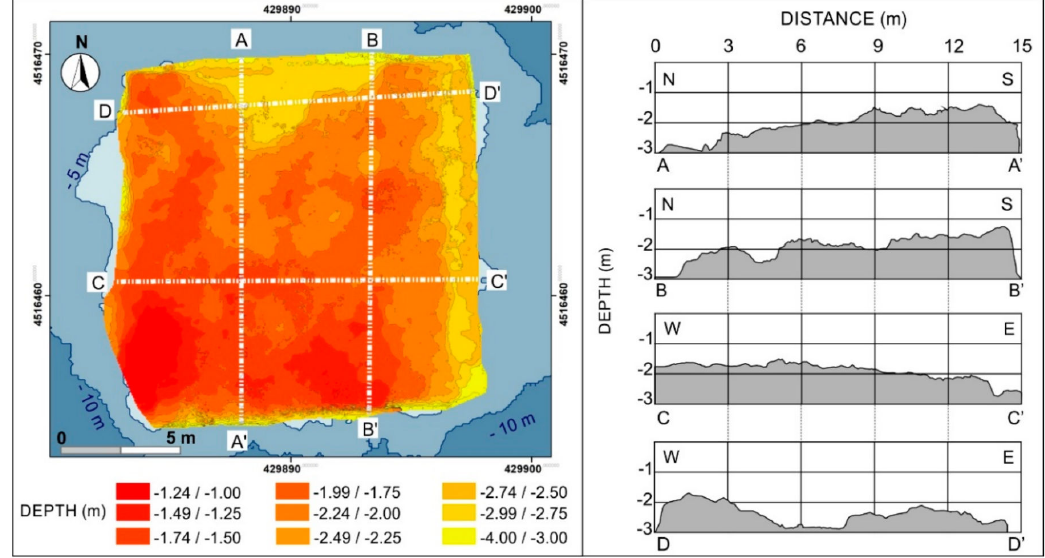
Figure 15. Three-dimensional reconstruction of the archaeological remains obtained by interpolating photogrammetric